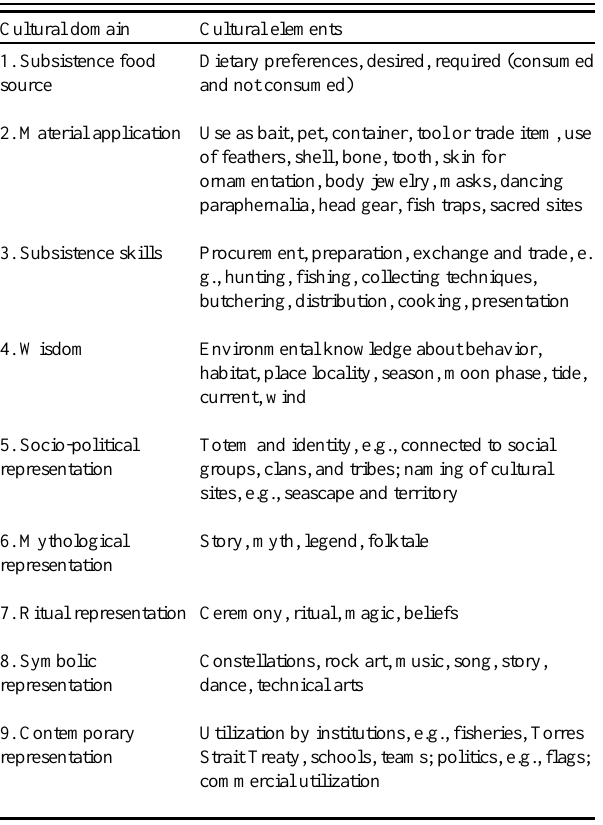
Table 1 . Smyth et al.’s (2006) nine cultural domains and elements applied to classify the cultural value of Torres Strait marine